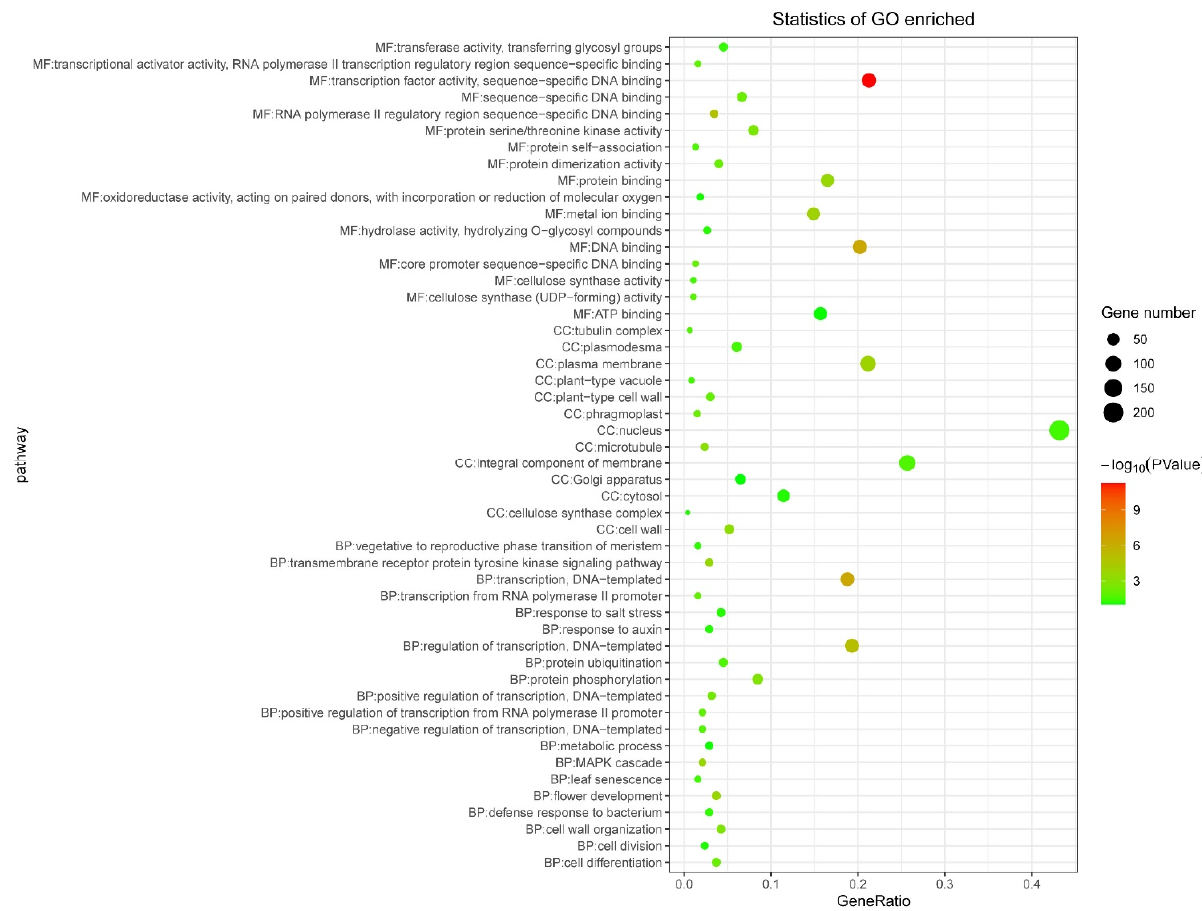
Figure 8. The bubble diagram of the top related genes in pepper SBP gene co-expression network. The GeneRatio refers to the ratio of genes enriched to all genes in a same pathway.